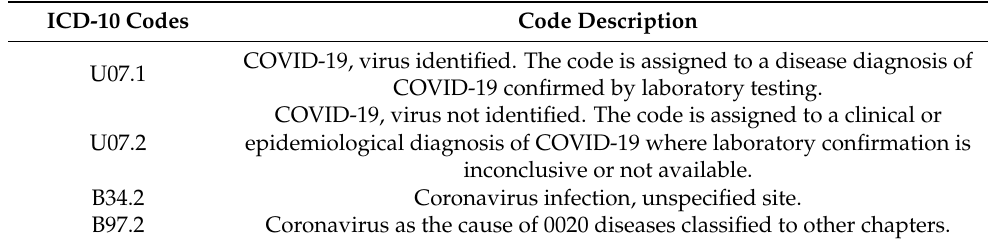
Table 1. COVID-19 Cases: Inclusionary ICD